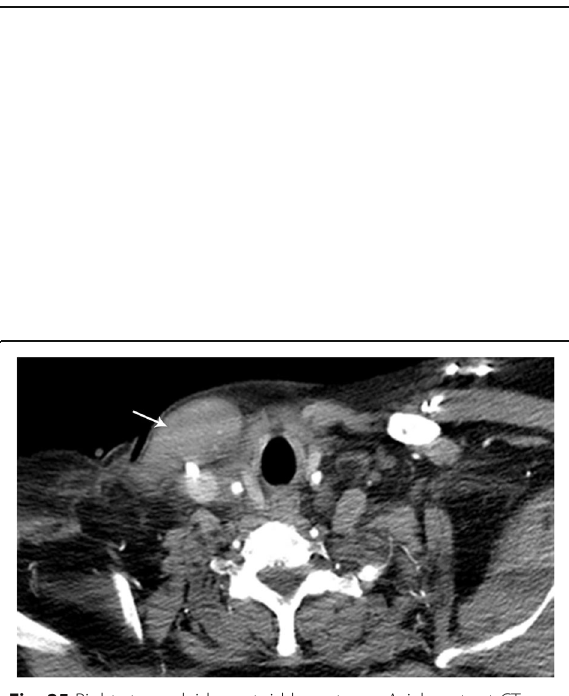
Fig. 24 Transection of the left axillary artery. Patient presenting with multiple traumatic fractures and a cold left arm. Coronal ( a ) contrast CT image demonstrates abrupt cutoff of the left axillary artery (white arrow), along with active extravasation of contrast material (black arrow). Coronal ( b ) contrasted CT images demonstrate associated hematoma (dashed circle) in this corresponding